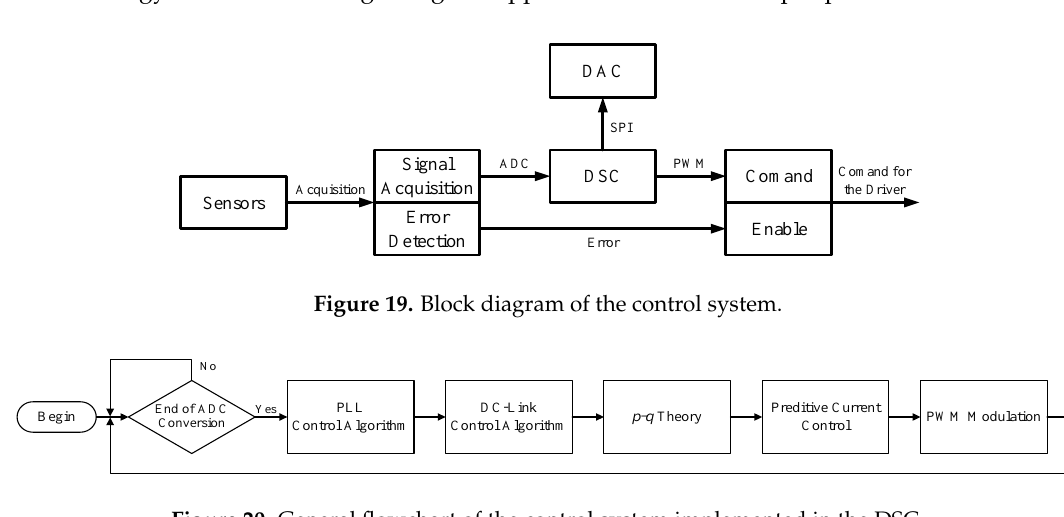
( b ) Figure 21. Experimental results of the Phase-Locked Loop (PLL) control algorithm: ( a ) PLL synchronization transient; ( b ) PLL in steady state. 6.2. Experimental Validation of the p-q Theory In this section are presented the experimental results from the p - q theory calculation. In the computer simulations, when implementing the p-q theory, the source voltage ( v S ) and the load